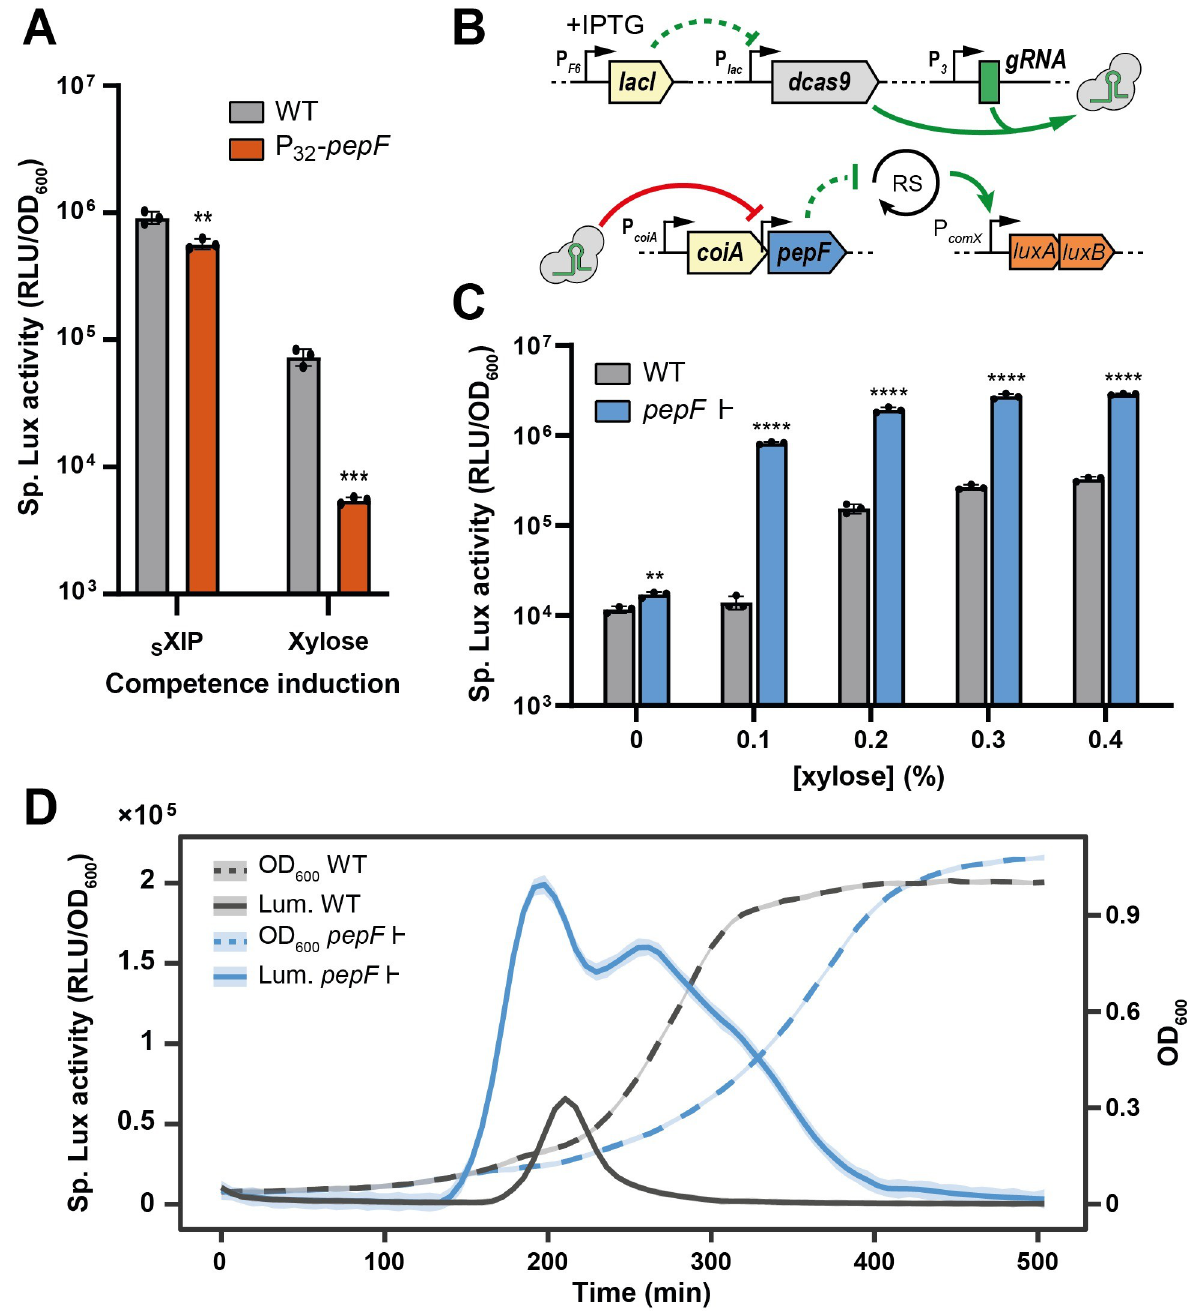
Fig 2. PepF down-regulates competence and constrains its activation to a limited time window. (A) Effect of pepF overexpression on P comX activity. Data show specific luciferase activity (RLU/0D 600 ) measured for WT (with P as proxy) compared to a strain carrying a comX -luxAB constitutive overexpression of pepF (P 32 -pepF ). Competence was activated thanks to synthetic XIP addition (sXIP, 50 nM) or comR overexpression via a xylose-inducible promoter fused to comR (P xyl2 -comR , 0.25% xylose). (B) Cartoon depicting the CRISPRi strategy used to repress pepF in panels C and D (RS: ComRS activation). (C) Effect of pepF inhibition on P activity. Data show specific luciferase activity measured for WT (with P comX comX - luxAB as proxy) compared to a strain expressing a guide targeting the promoter of pepF (P 3 -gRNA_9 ). Both strains carry the IPTG-inducible dCas9 ) together with a xylose-inducible promoter fused to comR (P ). Competence was activated at different xylose system (P F6 -lacI P lac -dcas9 xyl2 -comR concentrations (0, 0.1, 0.2, 0.3 and 0.4%) and the dCas9 repression system was activated at 100 μ M of IPTG. Dots show biological triplicates, the bar shows the mean, and error bar denotes standard deviation. Statistical t -test was performed for each condition in comparison to the related control (WT) ( �� , P < 0.01; ��� , P < 0.001; ���� , P < 0.0001). (D) Growth (OD 600 ) and kinetics of P comX specific luciferase activity (Lum.) monitored over time with ( pepF |-) or without pepF inhibition (WT). Data shown are the xylose 0.4% induction of panel C. Full lines and dashed lines are representative of the mean of biological triplicates, shaded lines represent standard deviation.